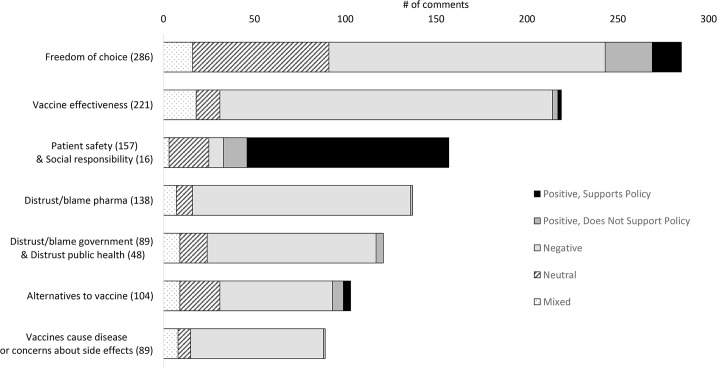
Seven most frequent themes and their distribution of sentiment.Freedom of choice, vaccine effectiveness, patient safety, distrust of the pharmaceutical industry, distrust of the government or public health, alternatives to vaccine, and concerns about side effects are the seven most frequently-appearing themes in our analysis.